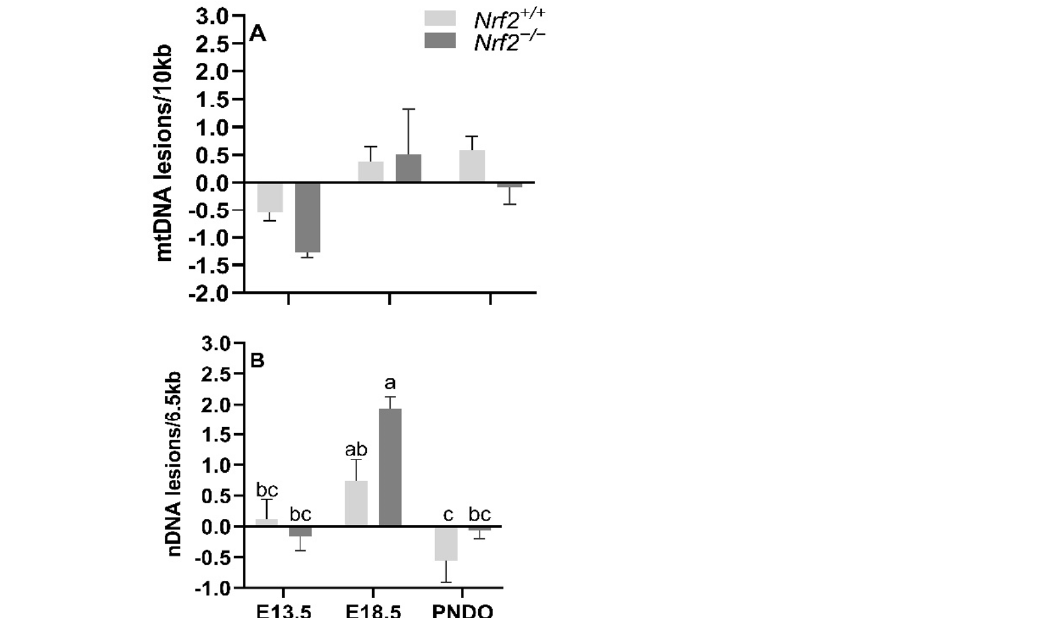
Figure 2B), but not in Nrf2 +/+ mice (E13.5: 0.11 ± 0.33 nDNA lesions/6.5 Kb,